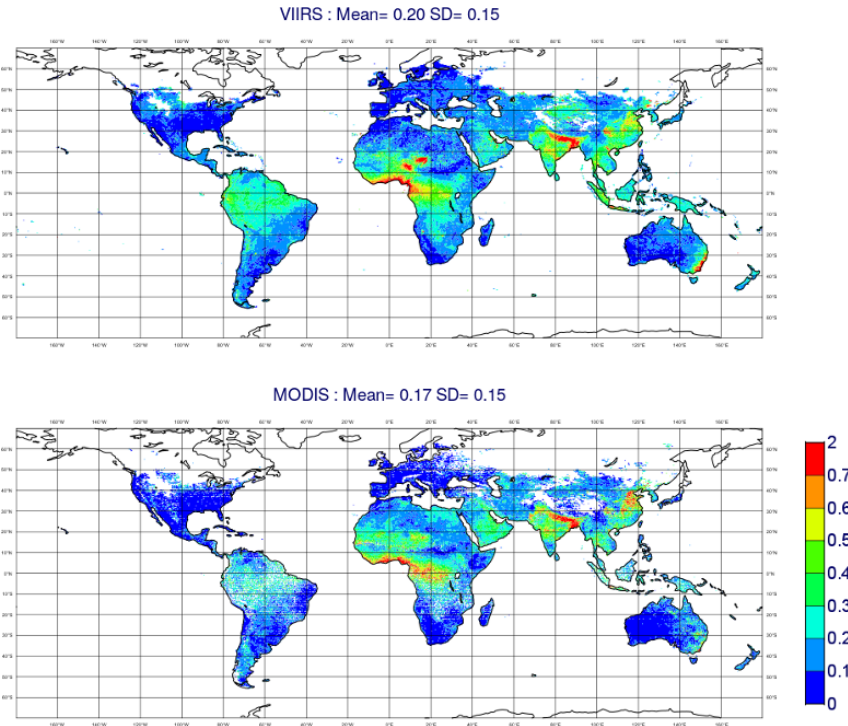
Figure 9. Global maps of temporal mean AOD from Terra and Aqua/MODIS as well as NOAA20 and SNPP/VIIRS for the DJF (2019–2020) period over land.